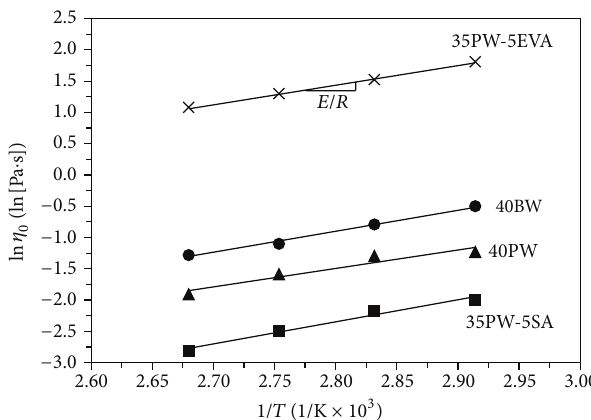
Figure 5: Viscosity of feedstocks as a function of temperature (at ̇𝛾 = 1160 s −1 ref